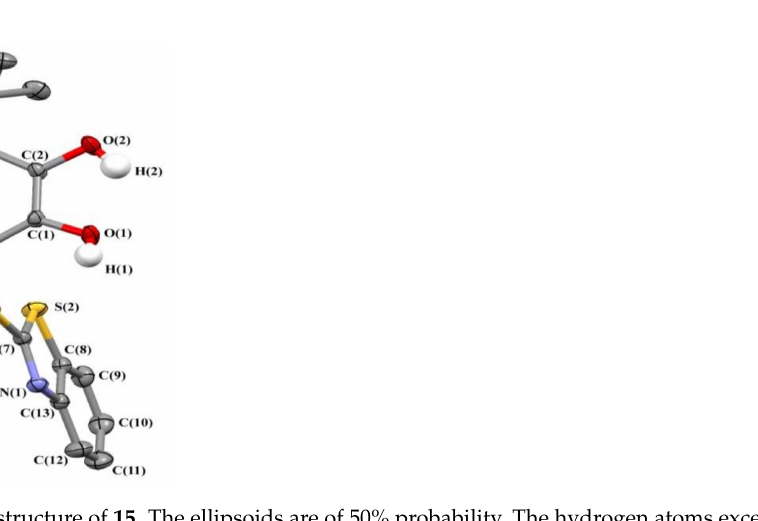
Figure 3. The X-ray structure of 15 . The ellipsoids are of 50% probability. The hydrogen atoms except for hydroxy groups are omitted. The selected bonds lengths (Å): O(1)–C(1) 1.370(2), O(2)–C(2) 1.376(2),